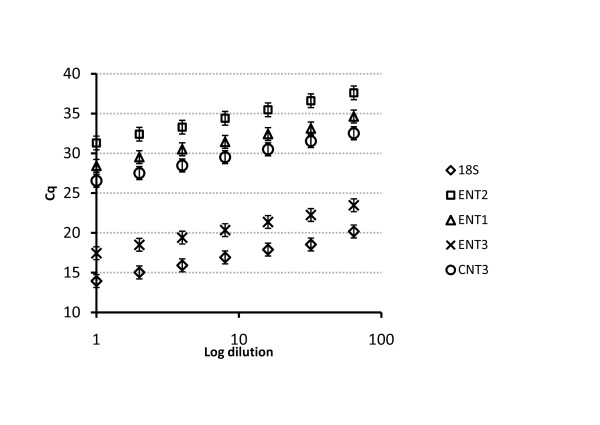
Validation of the method for fluorescence-based quantitative real-time PCR (qPCR). Titration curves were obtained by using cDNA to create a series of dilutions, from 1× (no dilution) to 64 × dilution. Then the qPCR was run and log dilutions plotted against the obtained quantification cycle (Cq) values. Each Cq value was estimated as an average from 2 replicates and each point in the Figure represents mean ± SE from 3 separate cDNA samples. The linearity of the plots shows the equal amplification of the assay over a range of input DNA concentrations. These data were also used to estimate the efficiency (E) of the reaction for each gene of interest.